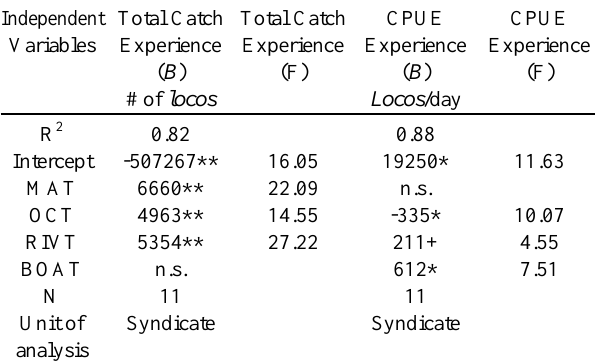
Table 4 . Experience-technology regression models of total locos caught in the 2003 season (TOTAL) and catch-per-unit effort (CPUE). Independent variables used in the analysis include: proportion of time spent in the management areas (MAT), ocean (OCT), the river (RIVT), as well as total number of boats